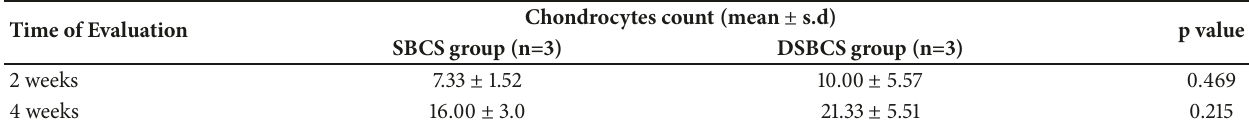
Table 4: Chondrocytes count in SBCS group and DSBCS